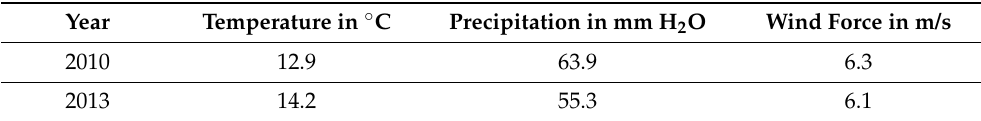
Table 1. Monthly average temperatures ( ◦ C), precipitation (in mm H 2 O) and wind force (in m/s) from the weather station at Teriberka (69 ◦ 1 (cid:48) N, 35 ◦ 1 (cid:48) E) located on the Barents Sea in July 2010 and 2013. The average temperature, precipitation and wind force in July 2010 and 2013 are given according to the weather station in Teriberka (69 ◦ 1 (cid:48) N, 35 ◦ 1 (cid:48) E) located on shore of the Barents Sea. Year Temperature in ◦ C Precipitation in mm H 2 O Wind Force in m/s 2010 12.9 63.9 6.3 2013 14.2 55.3